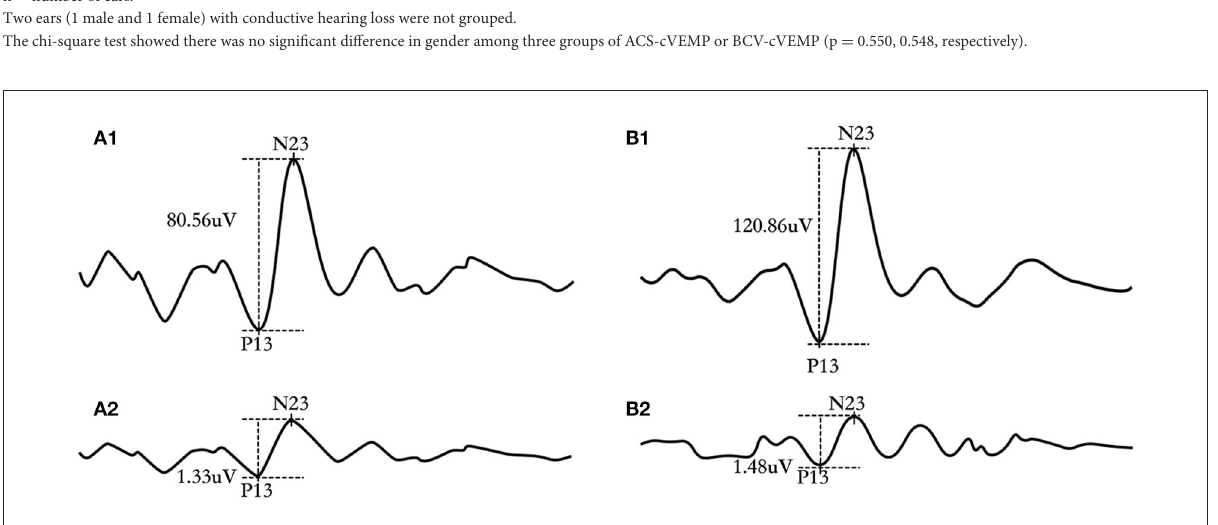
FIGURE2 Representative ACS-cVEMP and BCV-cVEMP waveforms of a 3-month-old infant with bilateral normal hearing. (A1) raw waveform of ACS-cVEMP; (A2) corrected waveform of ACS-cVEMP; (B1) raw waveform of BCV-cVEMP; (B2) corrected waveform of